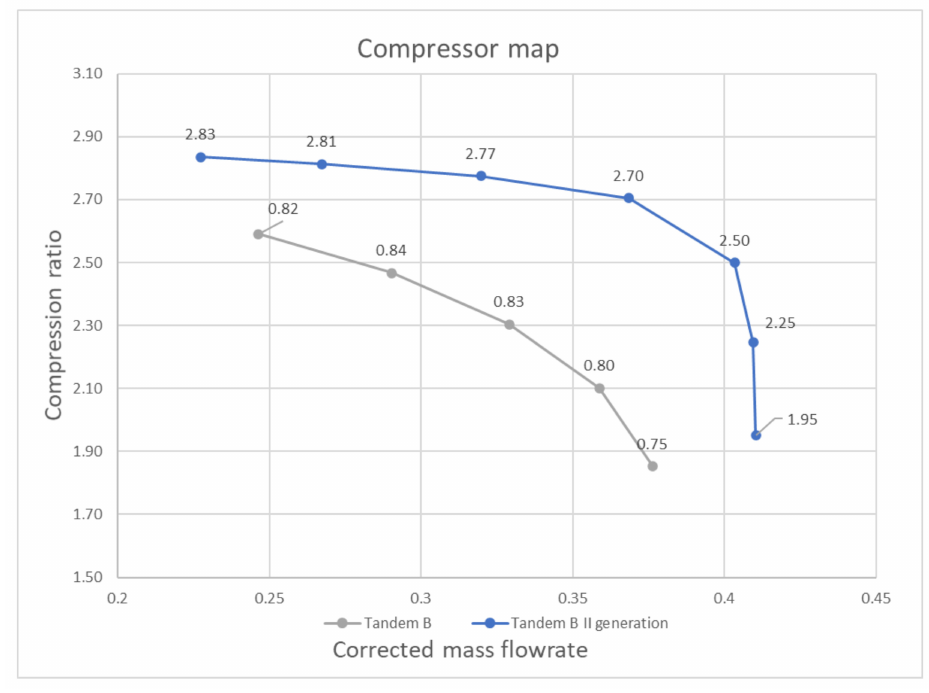
Figure 29. Compressor map